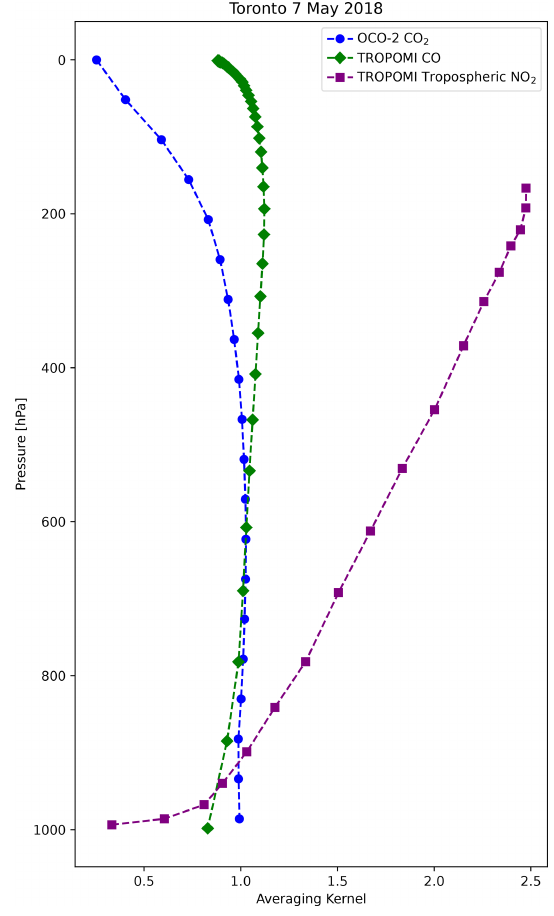
Figure C1. Averaging-kernel profiles for OCO-2 CO 2 , TROPOMI CO and TROPOMI NO 2 over Toronto on 7 May